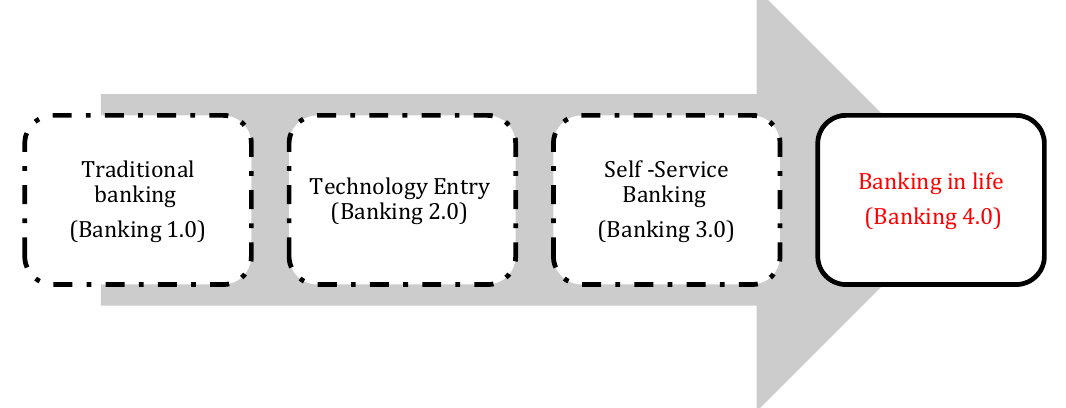
Figure 4. The banking revolution. Source: Own contribution of the authors.